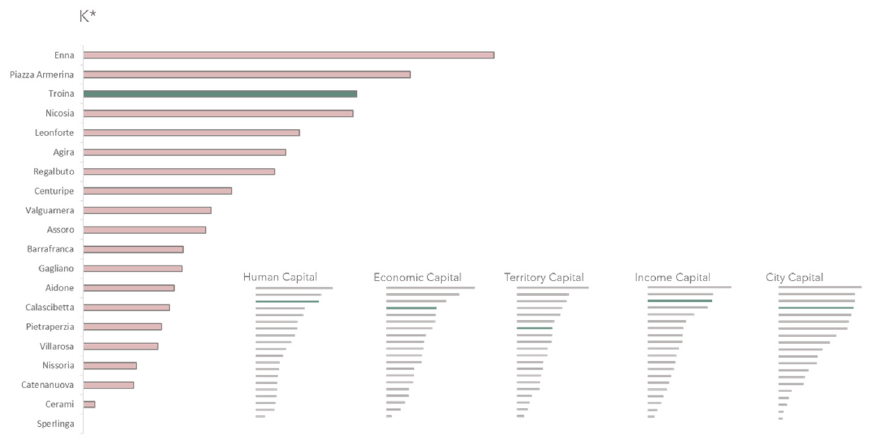
Figure 16. Ranking of the Municipalities basing on the overall normalized score k* and the partial valuations from the points of view of the five forms of social-economic capital asset.